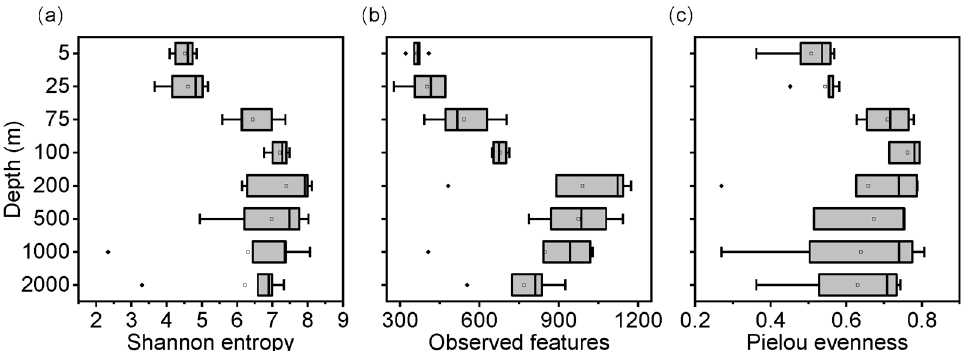
Figure 5. Depth profiles of bacterial alpha diversity indices. ( a ) Shannon entropy, ( b ) Observed features (richness), and ( c ) Pielou’s evenness. The box in the plot represents the interquartile range (IQR), which ranges from the first to third quartiles. The line within the box represents the median. The whiskers extend from the box to the smallest and largest values within 1.5 times the IQR. Any values beyond the whiskers are plotted as individual data points, which may be considered outliers.